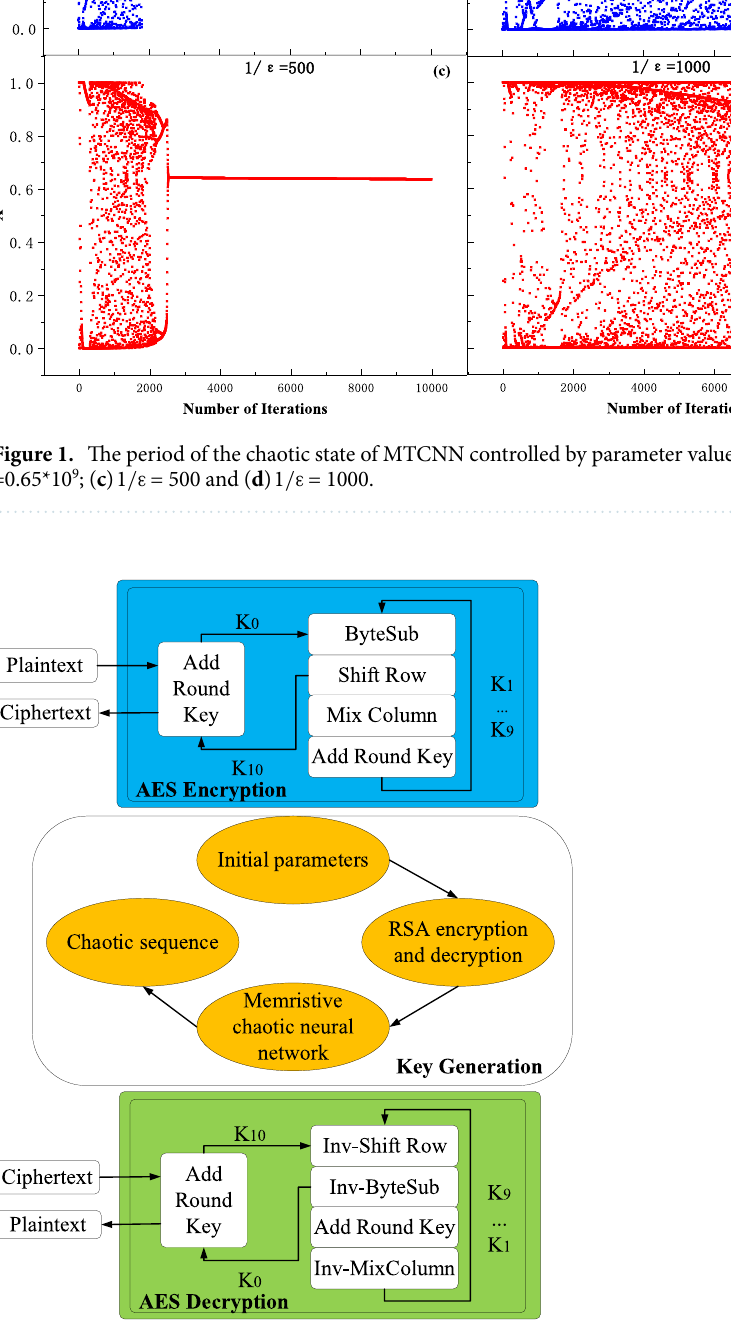
Figure 2. Schematic illustration of the proposed AES encryption and decryption process based on